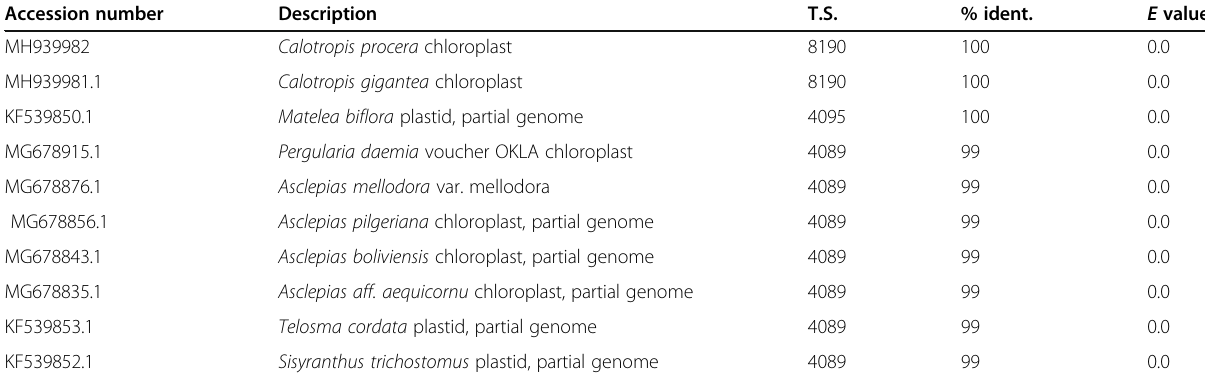
Table 2 Accession number for each DNA sequence, description, organism name, T.S., % ident., and E value of homologous sequence to C. procera ndhB gene sequence identified using BLAST